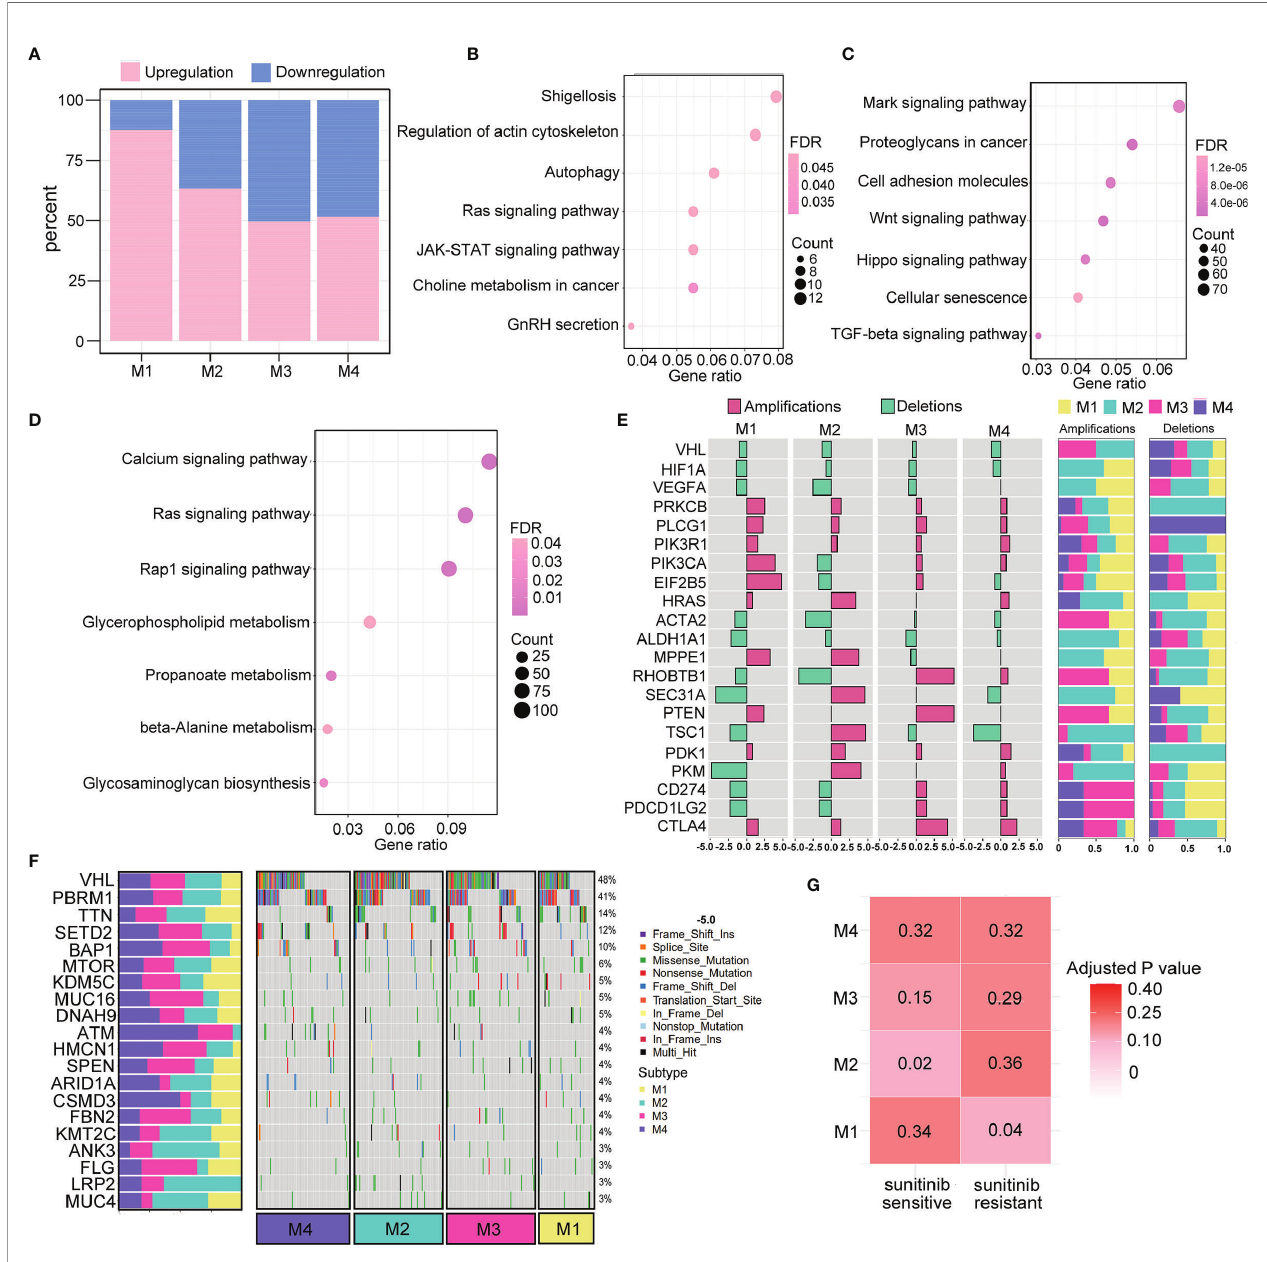
FIGURE 7 | Genomic and epigenomic features of the immunometabolism subtypes. (A) Percentage of signi fi cantly down- and upregulated miRNAs in TCGA across four subtypes. (B , C) Pathway analysis of target genes regulated by up- and downregulated miRNAs of M3 subtype. (D) Pathway analysis of M1-speci fi c hypermethylated genes. (E) Subtype-speci fi c CNV (deletions or ampli fi cations) enrichment is presented as odd ratios with FDR <0.05. The proportion of deletion events and ampli fi cation events in the four subtypes are denoted on the right. (F) Waterfall of mutation status of the top 20 most mutated genes among the four subtypes. The proportion of mutation rates of the corresponding genes in the four subtypes is denoted on the left. (G) Correlation analysis of immunometabolism subtypes and patients who are sensitive or resistant to sunitinib targeted drug